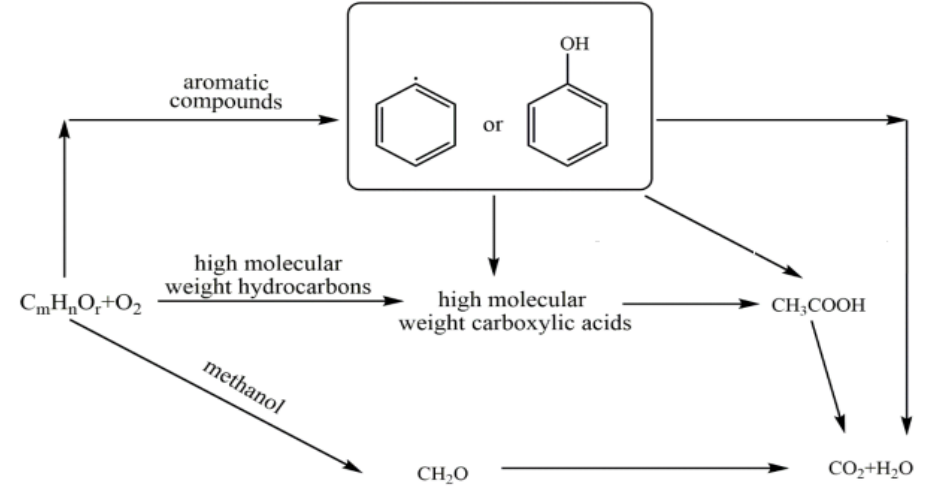
Figure 8. The simplified reaction network for hydrocarbon oxidation in SCW [59].